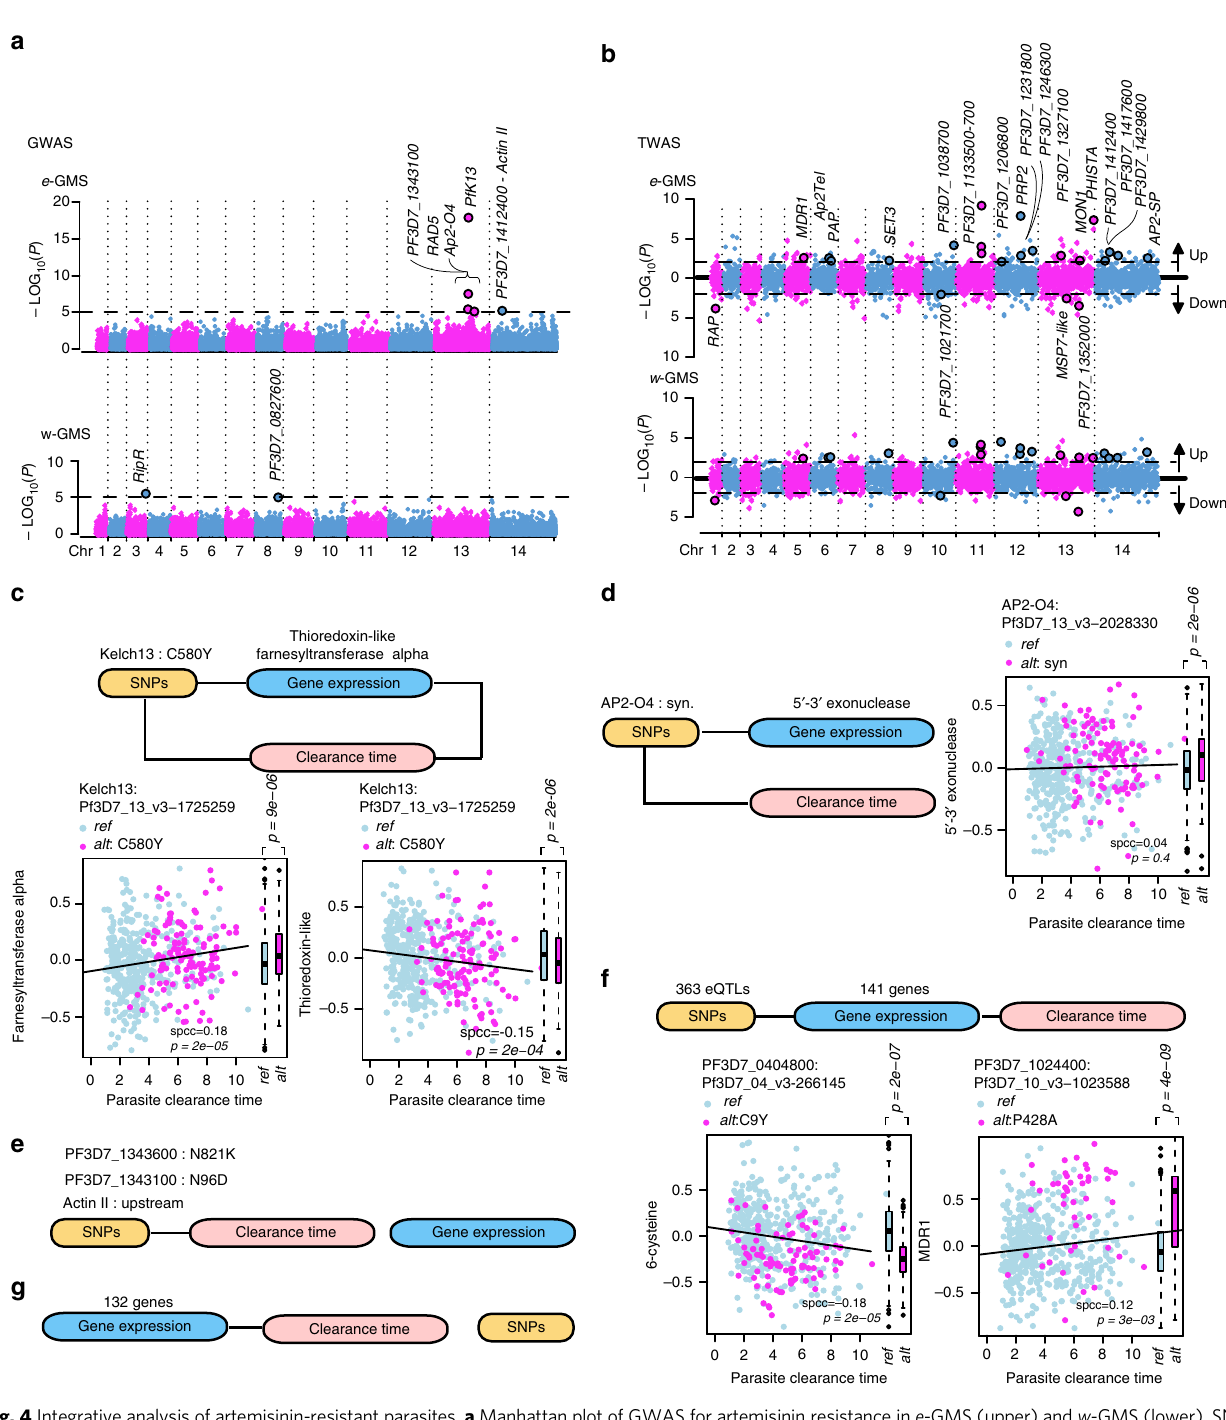
Fig. 4 Integrative analysis of artemisinin-resistant parasites. a Manhattan plot of GWAS for artemisinin resistance in e -GMS (upper) and w -GMS (lower). SNPs passing p -value<1e − 5 are displayed in black circles above dot lines. b Manhattan plot of TWAS for artemisinin resistance. Upregulated and downregulated genes displayed in two directions (Up and Down) were de fi ned by positive and negative Spearman ’ s rho. The horizontal dotted lines represent p -value = 0.01 (Spearman ’ s rho test). Genes observed in both w - and e -GMS at p -value<0.01 (Spearman ’ s rho test) and FDR<0.25 (Benjamini & Hochberg correction) are black circled and labeled with gene name/id in the e- GMS plot. The relationships between parasite clearance time (pink blocks), gene expression (blue blocks) and SNP markers (yellow blocks) in e- GMS are characterized into fi ve putative causality modes. c SNP affects clearance time dependent on expression and vice versa. d Clearance time and expression independently affects same SNP(s). e SNP affects clearance time independent of expression. f Expression mediated genetic effects on clearance time. g Expression affects clearance time independently of SNPs. Blocks are linked at p -value<1e − 05 for SNP-expression (eQTL) and SNP-clearance time (GWAS), and at p -value<0.01 and FDR<0.25 for expression-clearance time (TWAS). Corresponding gene/SNP name(s)/ID(s) or numbers are listed above blocks accordingly for each mode. Examples of resistance-associated relationships are shown in scatterplots with genes of farnesyltransferase (PF3D7_1242600) and thioredoxin-like (PF3D7_0717699) for mode c , 5 ′ – 3 ′ exonuclease (PF3D7_0204600) for mode d , 6-cysteine (PF3D7_0404900) and MDR1 (PF3D7_0523000) for mode f . Light blue used in scatterplots stand for isolates with reference alleles (ref.) and magenta for the alternative (alt). Expression is compared between alleles in boxplot on the right for each gene with the eQTL p -values labeled